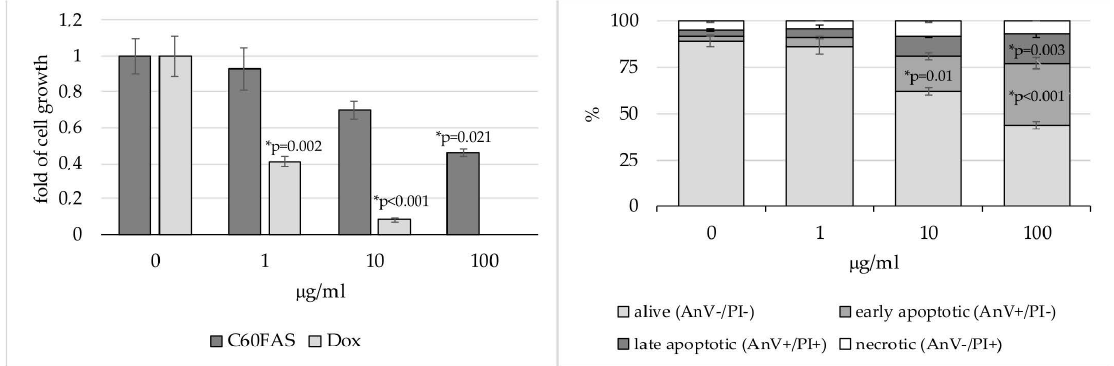
Figure 2. HepG2 cell viability after 48 h cultivation in medium contained C 60 FAS or Dox as a reference ( left panel ) and distribution according to alive, apoptotic and necrotic cell pools after 48 h cultivation in medium contained C 60 FAS ( right panel ); * compared to respective control ( p -values provided if p < 0.1).